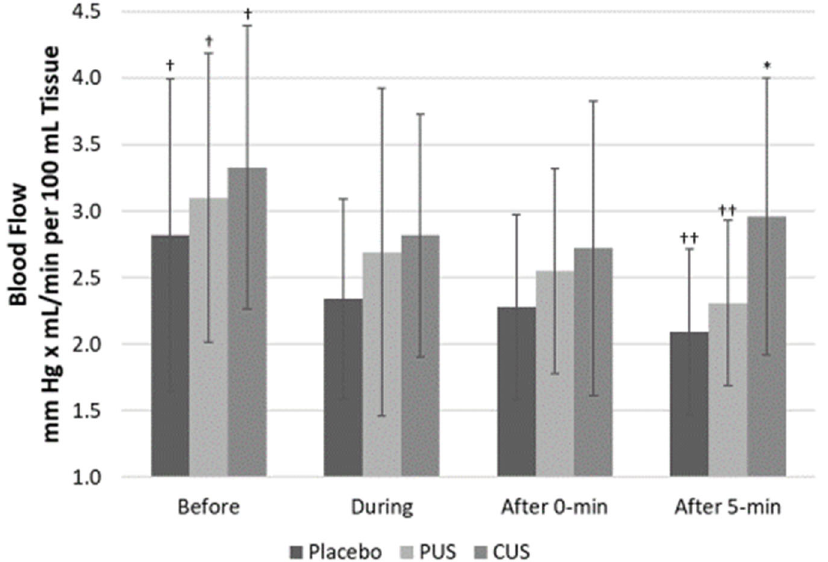
Figure 2. Forearm blood flow before, during, and after therapeutic ultrasound application. Data presented as average and S.D. PUS: pulsed ultrasound; CUS: continuous ultrasound; * p < 0.05 CUS vs. Placebo 5 min after application; †: p < 0.05 Placebo, PUS, and CUS before vs. 0 min after application; ††: p < 0.05 Placebo and PUS before vs. 5 min after application. PUS resulted in the greatest increase in peak FBF at 10 min after TUS ( Δ = 3.96 ± 2.02 mL/min/100 mL of tissue, p = 0.060). Placebo and CUS displayed no increase in peak FBF at 10 min after (Figure 3).